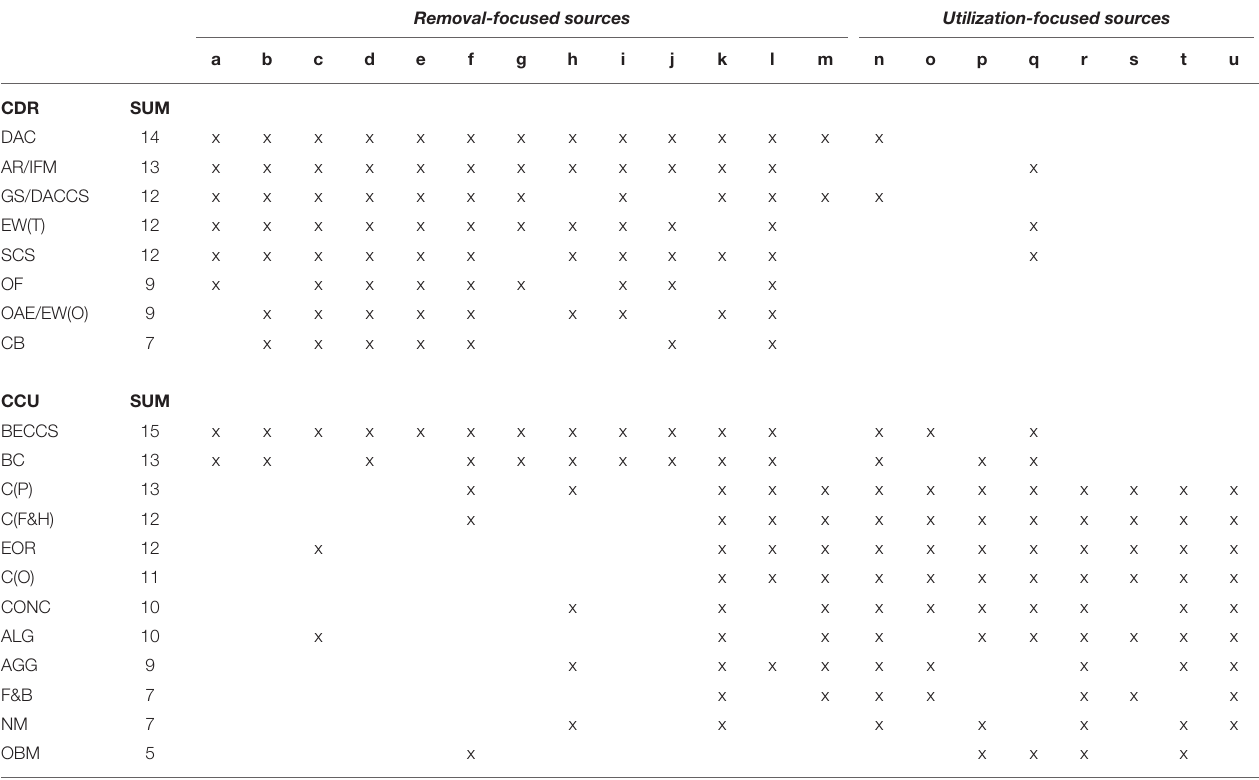
TABLE 1 | Typology of carbon removal and carbon utilization